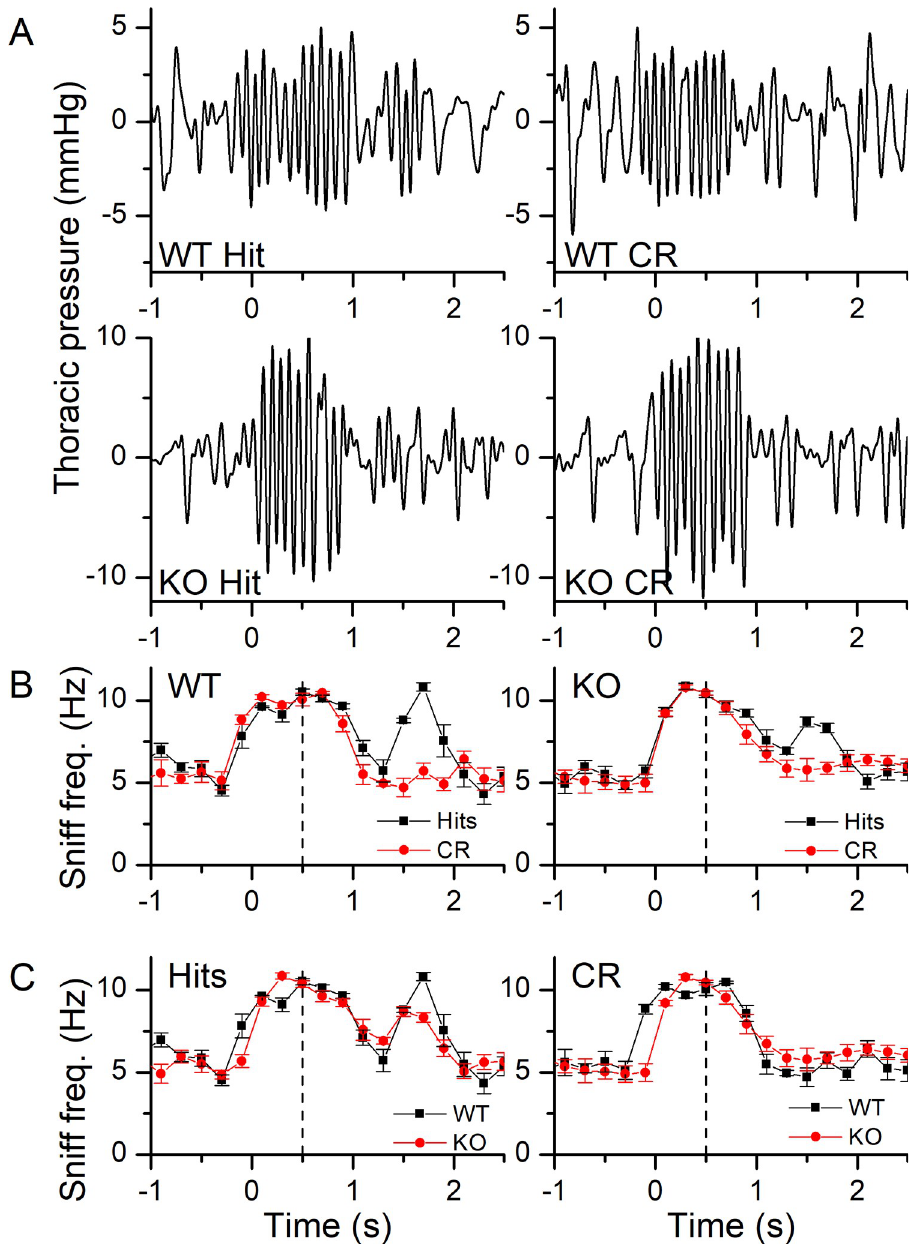
Fig 3. Recordings of thoracic pressure changes during odorant sampling of different odorant concentrations. A The thoracic pressure during a Hit (left) and a CR (right) trial in a WT and a KO mouse when exposed to 10 − 4 propanol. Time 0 marks the nose poke into the odor port and the start of the trial. Odorant delivery occurred at 0.5 s. B The sniff frequency of a WT (left) and a NCKX4 KO (right) mouse when tested with 10 − 4 propanol or mineral oil odor. C Comparison of Hits (left) and CRs (right) between WT and KO mice. Sniff frequencies were binned in 0.2 s bins according to their behavioral outcome and averaged (mean ± SEM) across trials of one block of 20 trials. Vertical dashed line indicates odorant